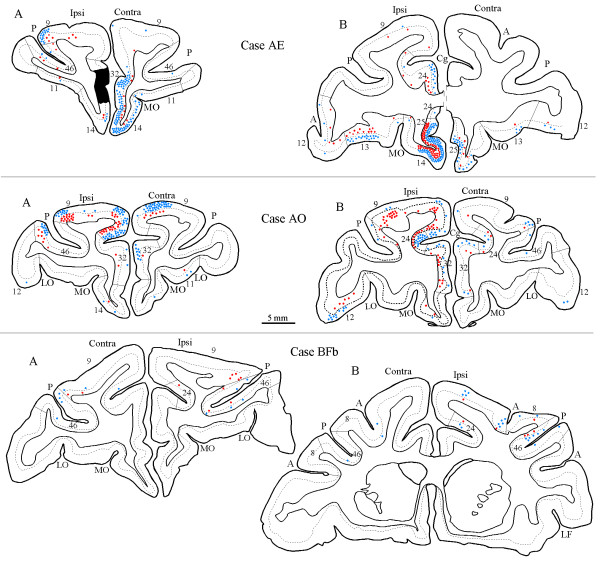
Bilateral distribution of projection neurons directed to medial prefrontal and lateral prefrontal cortices. Coronal sections through the prefrontal cortex showing labeled neurons in ipsilateral (ipsi) and contralateral (contra) hemispheres after infection of tracers in three cases. Labeled neurons were found in layers II-III (blue dots) and in layers V-VI (red dots). In all cases rostral sections are shown on the left, and caudal on the right. (Top) Injection of HRP-WGA (A, black area) was in medial area 32. (Center) Injection of HRP-WGA was in medial area 9 (not shown). (Bottom) Injection of fast blue was in dorsal area 46 (not shown). Dotted lines through the cortex in the coronal sections show the bottom of layer IV. Abbreviations as in Figure 5.